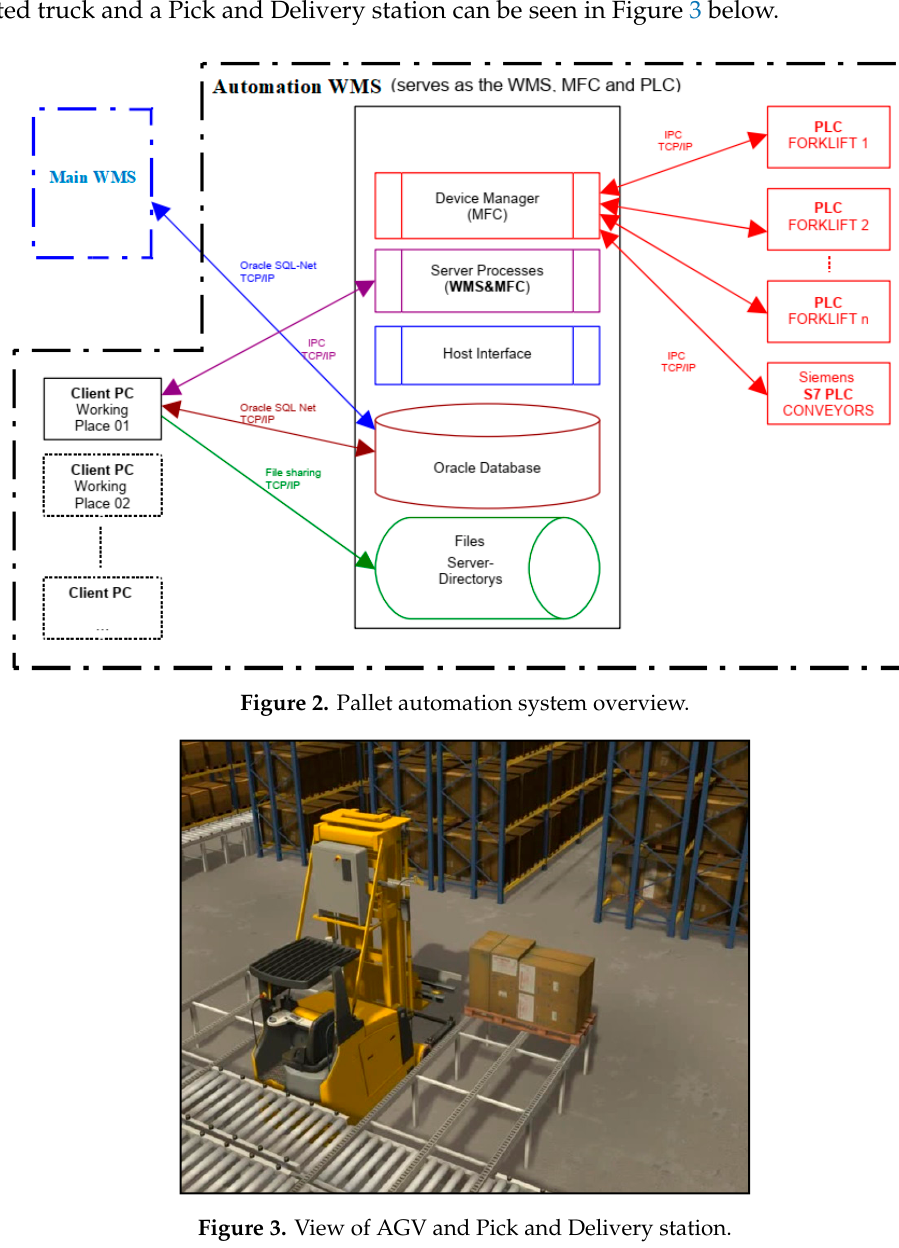
Figure 3. View of AGV and Pick and Delivery station.